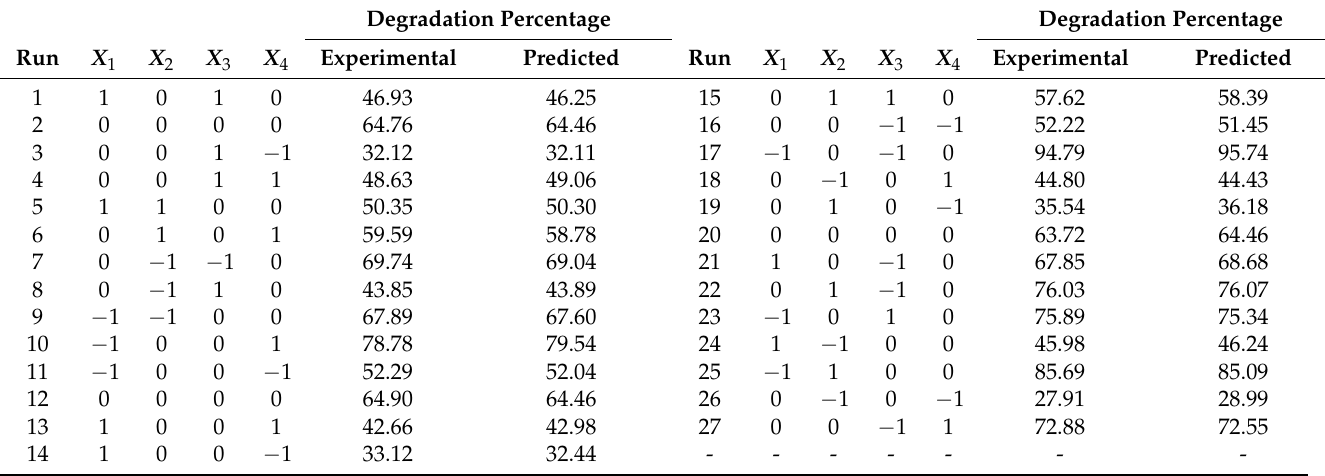
Table 3. Experimental conditions of coded variables for the various runs of Box-Behnken design and the obtained experimental and predicted MO photocatalytic degradation